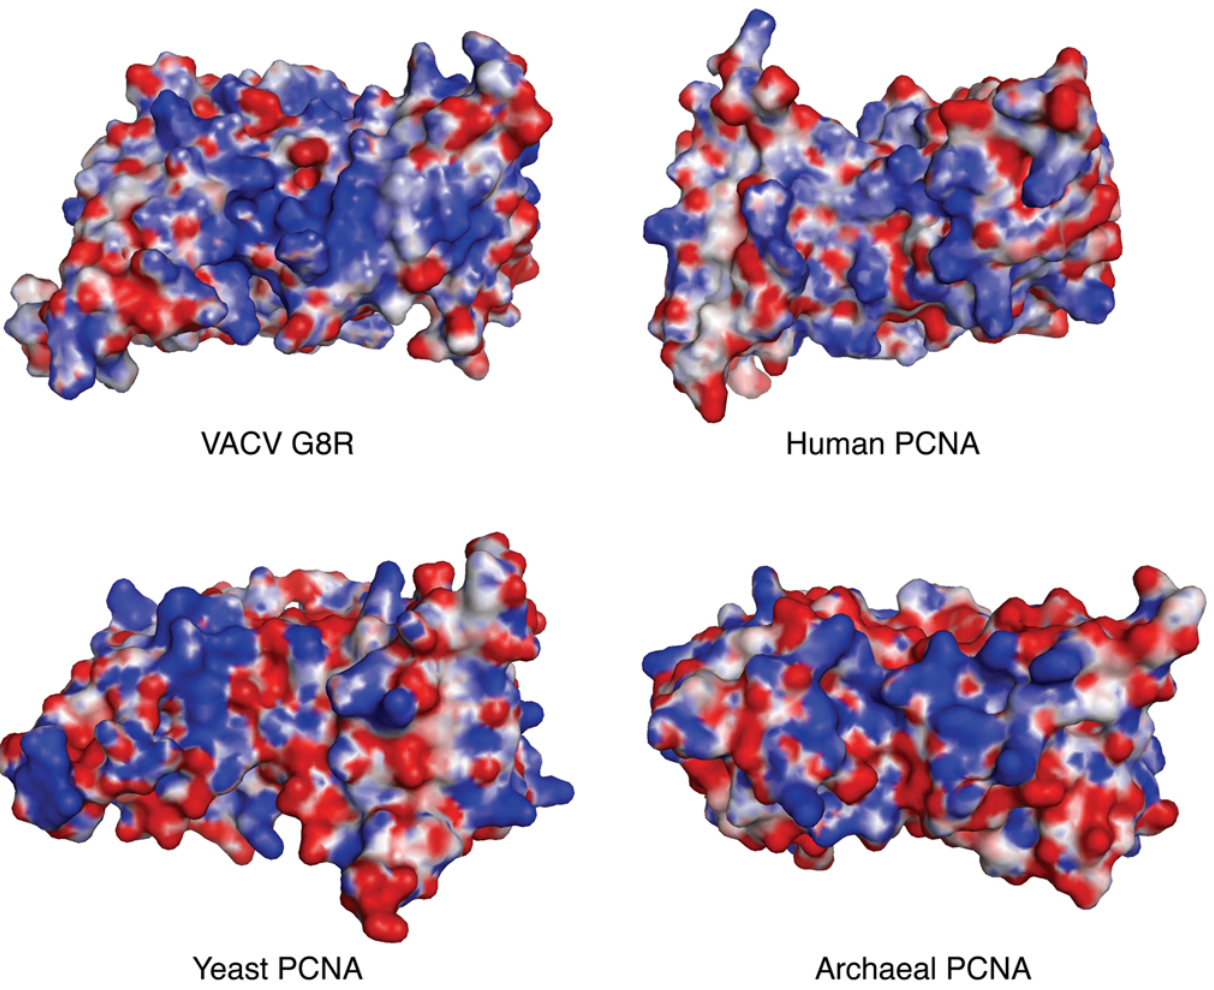
Figure 6. Electrostatic surface diagrams of the VACV G8R protein and 3 other PCNA proteins. Surface diagrams are coloured by electrostatic properties as calculated by APBS using all default values with positively charged regions coloured in blue and negatively charged regions in red.